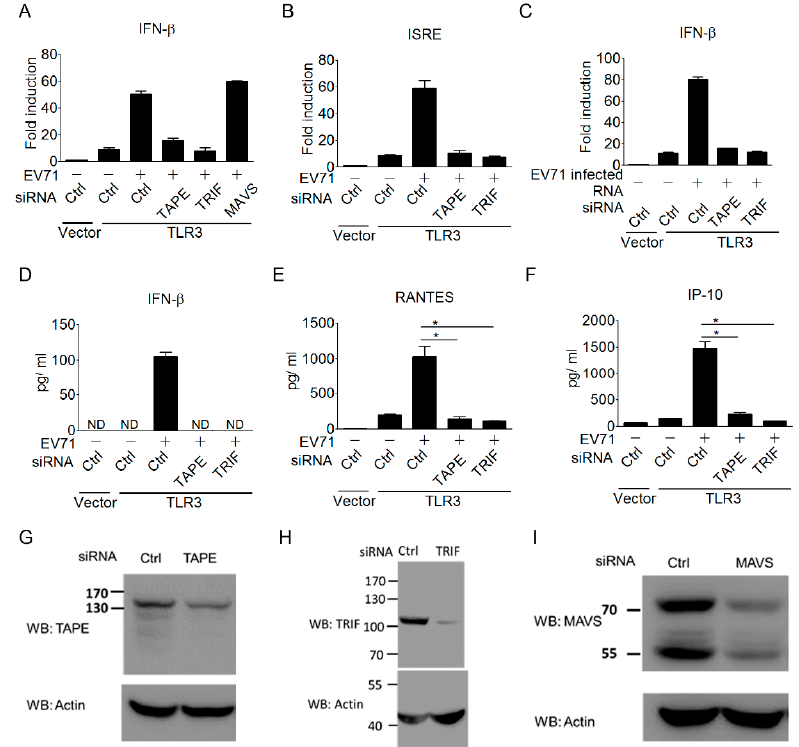
Figure 3. TLR3 downstream signaling is essential for triggering a type I IFN response to EV-A71 infection. (A, B) HEK293 cells were treated with the indicated siRNAs targeting Trif, TAPE, and MAVS for 48 h, and the cells were subsequently transfected with Flag-tagged TLR3 and an IFN- β (A) or ISRE (B) reporter plasmid. These cells were infected with EV-A71 (MOI, 0.1) for 40 h, and were then harvested for luciferase assays. (C) Like panel A, EV-A71-infected RNA was used to stimulate cells by DOTAP lipofection, and then the IFN- β promoter activity was measured using luciferase assays. (E to F) HEK293 cells were treated as in Panel B, with no transfection of the ISRE reporter plasmid. Supernatants from the treated cells were measured using ELISA for the production of IFN- β (D), RANTES (E), and IP-10 (F). (G to I) Western blot analyses of endogenous TAPE (G), TRIF (H), and MAVS (I) in HEK293 cells treated with indicated siRNAs or control siRNA. ND means “not detected.” * p < 0.05, Student’s t